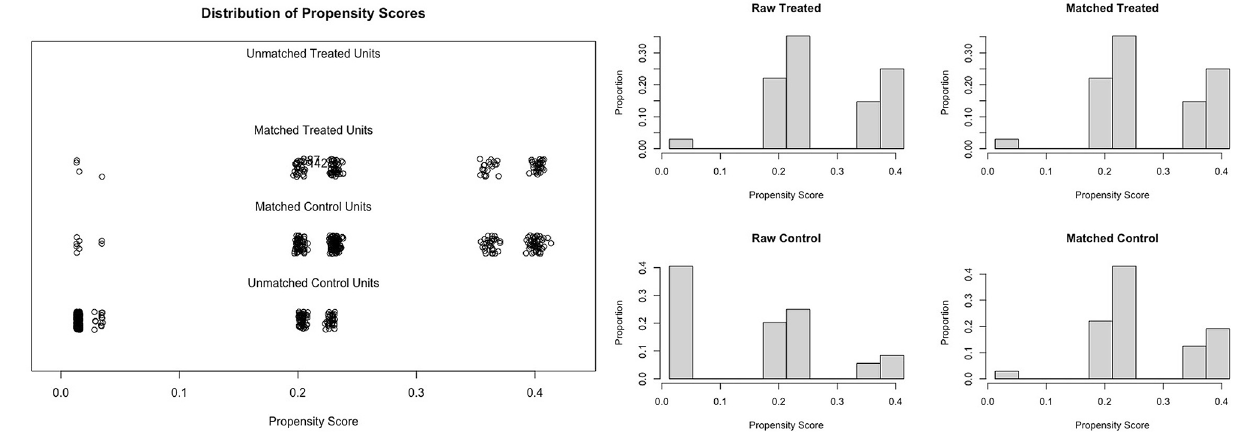
Figure 2. Distribution of propensity score before and after matching.